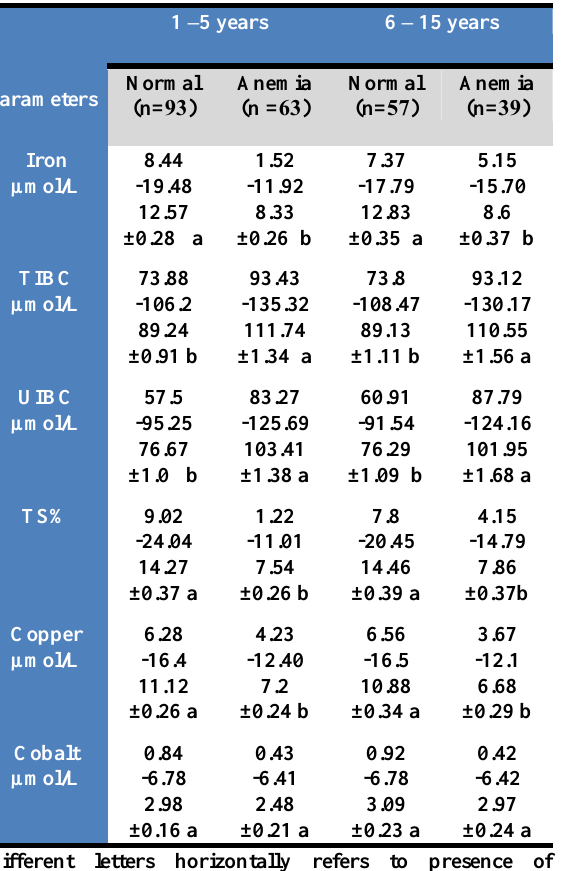
Different letters horizontally refers to presence of significant (P<0.05) differences